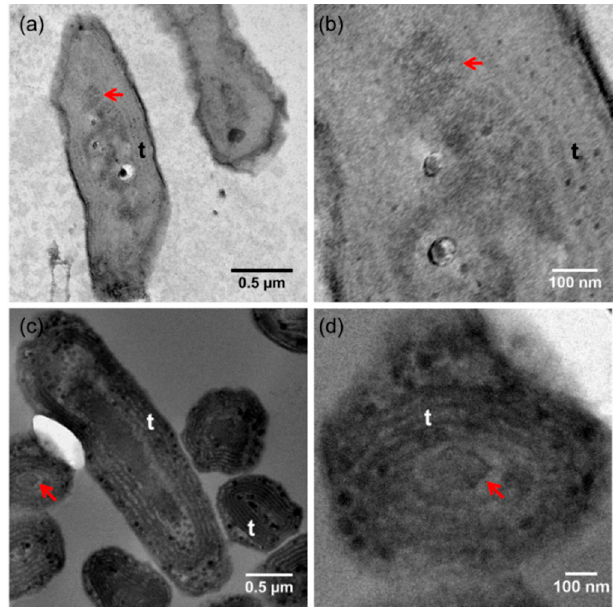
Figure 12. Bright-field TEM image of ultramicrotomy thin section of strain Ca . G. lithophora C7 ( a , b ) and strain Ca . S. calcipolaris G9 ( c , d ). The red-line arrows indicate possible carboxysomes. t thylakoid membranes.